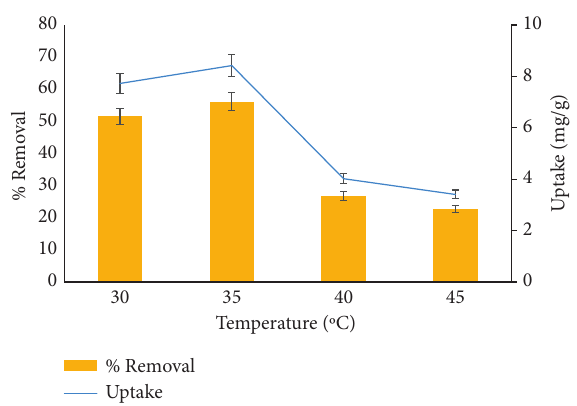
Figure 5: Effect of temperature on the sorption capacity and RR120 removal.